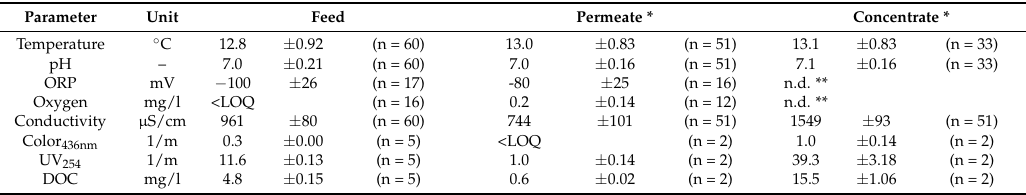
Table 1. Water quality feed, permeate, and concentrate; feed: well water. Parameter Unit Feed Permeate